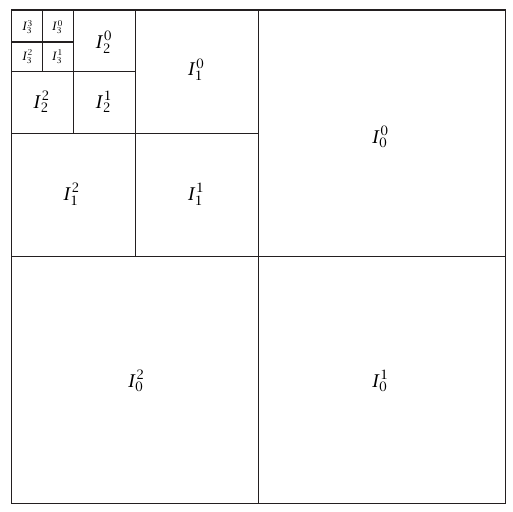
Figure 2: Wavelet decomposition of image I .